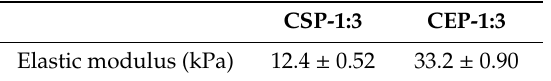
Table 2. Elastic moduli of CSP-1:3 and